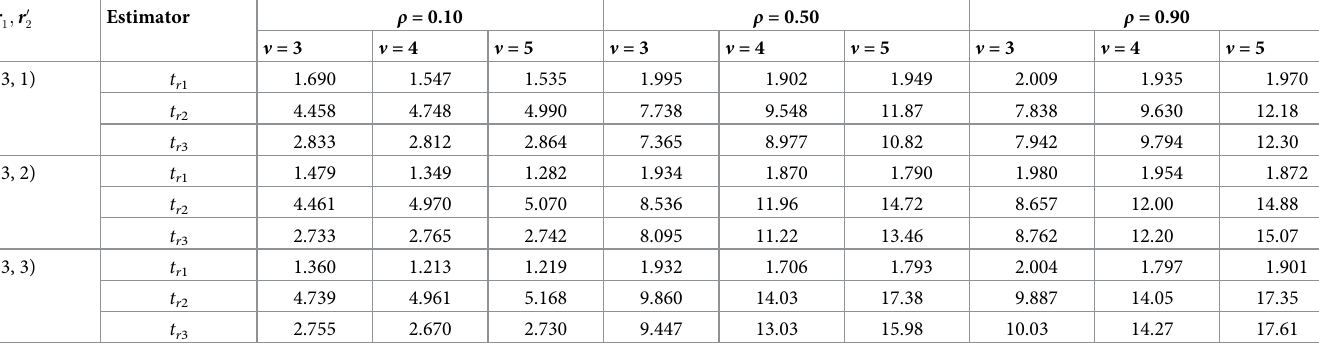
Table 6. RE of proposed class of estimators for Situation-II when k = 4. Estimator r 1 ; r 0 2